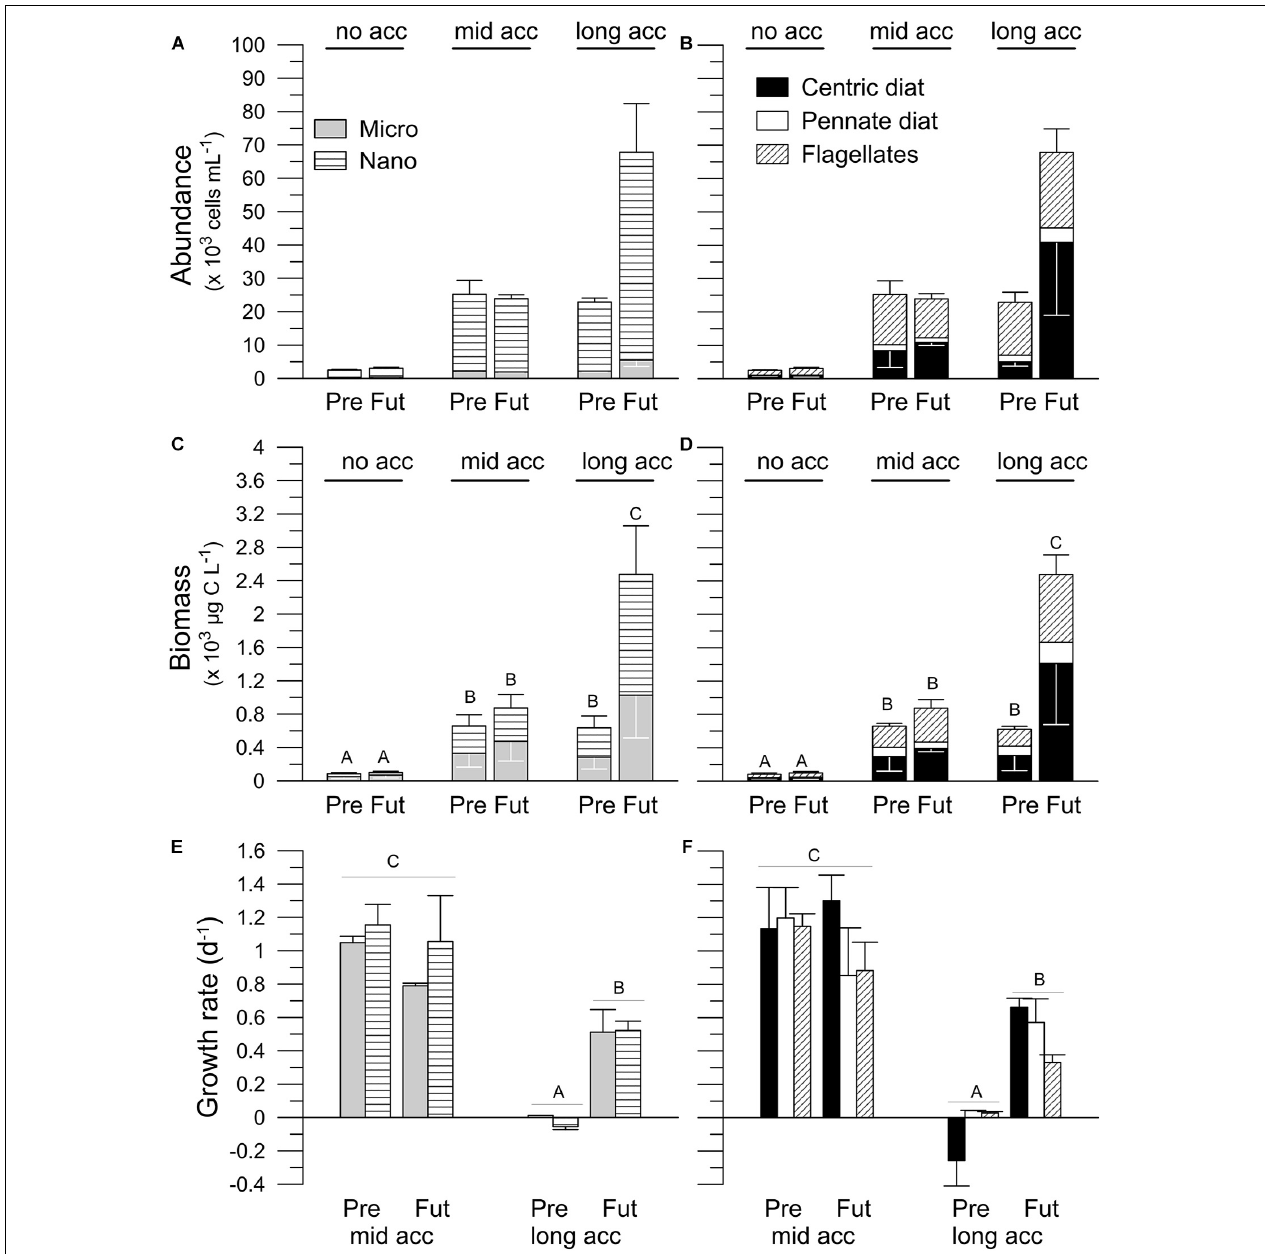
FIGURE 6 | Phytoplankton community structure: size (micro and nanoplankton) and groups (centric diatoms: Cent, pennate diatoms: Penn, and flagellates: Flags) in terms of cell abundance (A,B) and biomass (C,D) , and growth rates (E,F) for the different stages of acclimation (no, mid- and long acclimation) to the Present (Pre) and Future (Fut) scenarios for samples collected in Playa Unión. Capital letters indicate the post-hoc results for the interaction acclimation × scenario (3-way ANOVAs). Lines on the top of the bars indicate standard